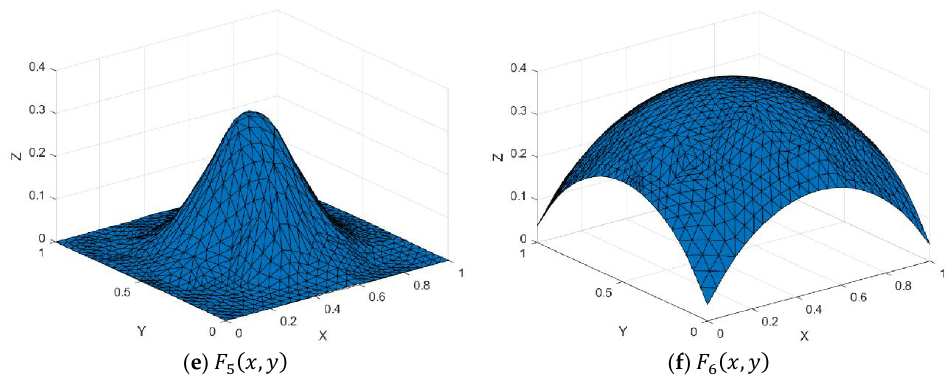
Figure 20. Surface interpolation using Goodman and Said method and Choice 1 for 100 datasets.